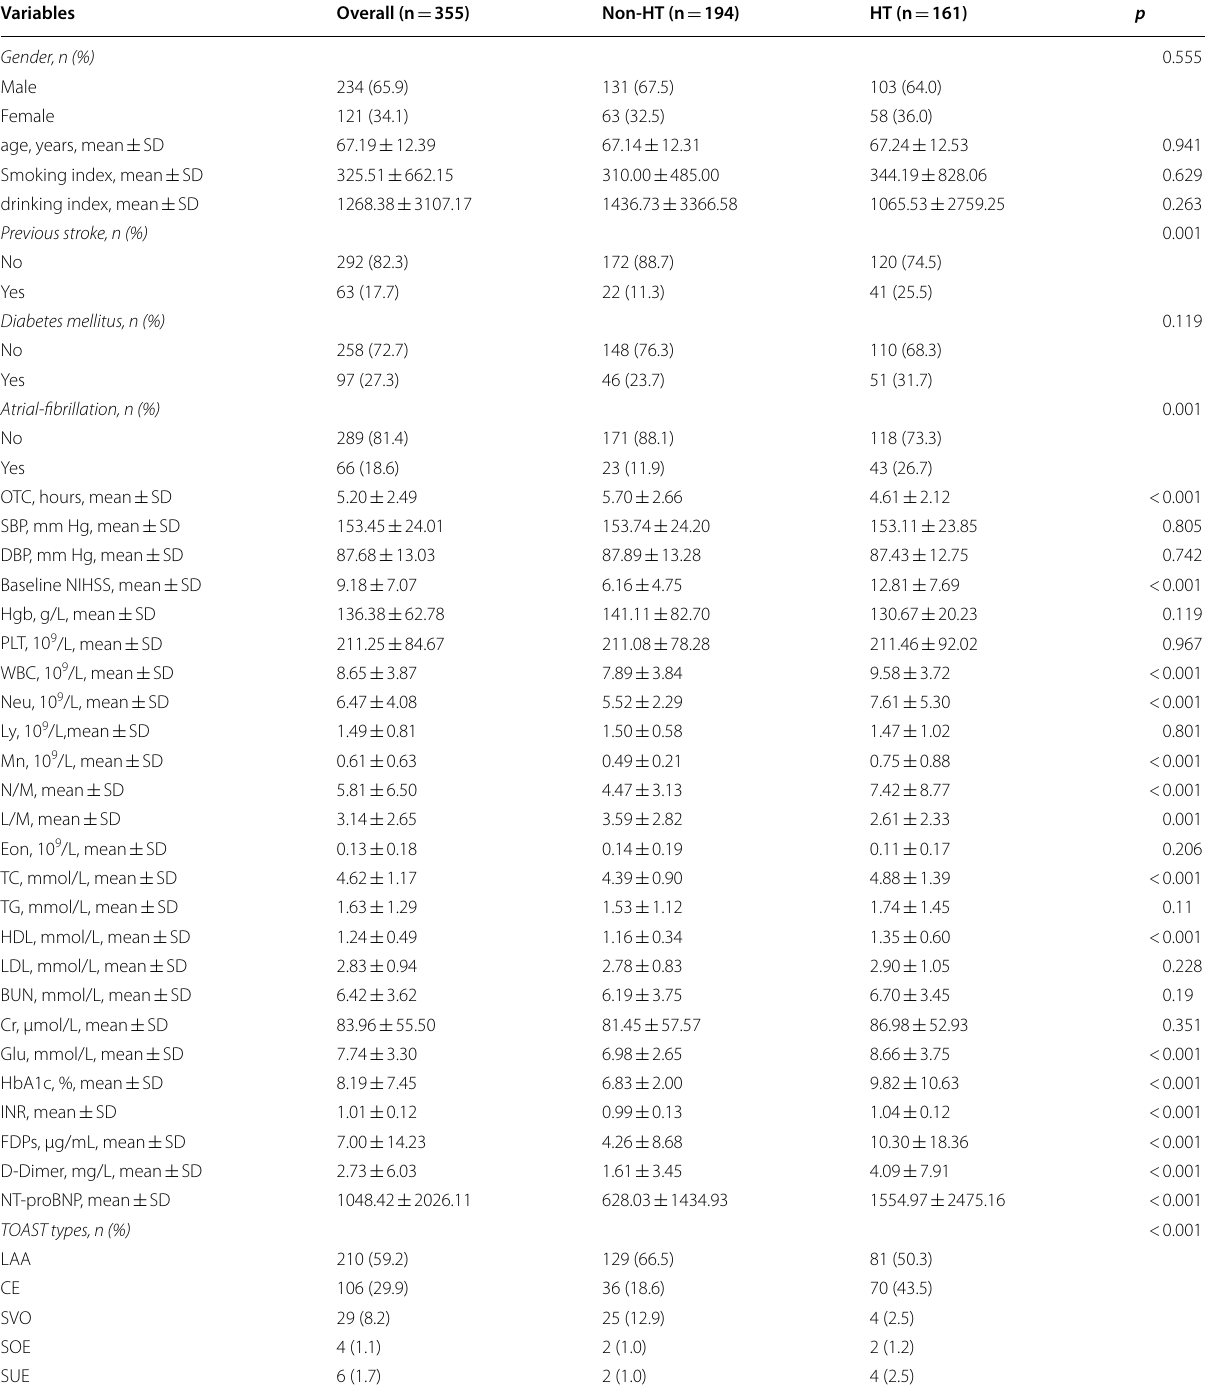
Table 5 Univariate analysis for HT in the training